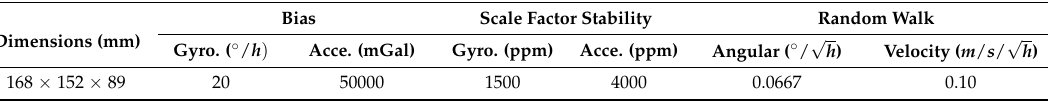
Table 1. Performance specifications of the IMU